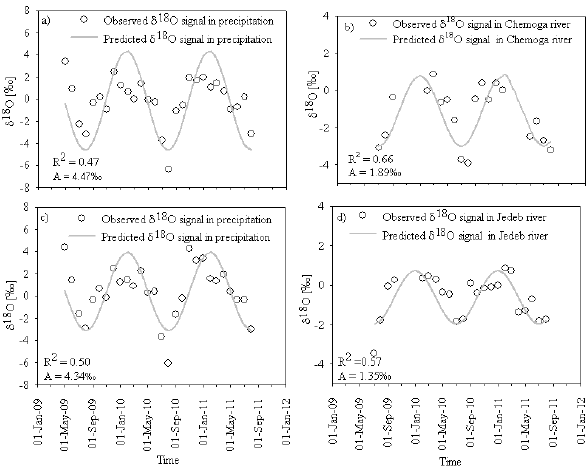
Figure 13. Fitted sine wave regression models to δ 18 O values for Fig. 13. Fitted sine wave regression models to δ 18 O values for precipitation and river water a) precipitation and river water (a) and (b) in the Chemoga, and (c) and and b) in the Chemoga, and c) and d) in the Jedeb river. Inside the figures, R 2 is the (d) in the Jedeb river. Inside the figures, R 2 is the coefficient of coefficient of determination, and ‘A’ is the amplitude for the input and output isotope signals. determination, and “A” is the amplitude for the input and output isotope